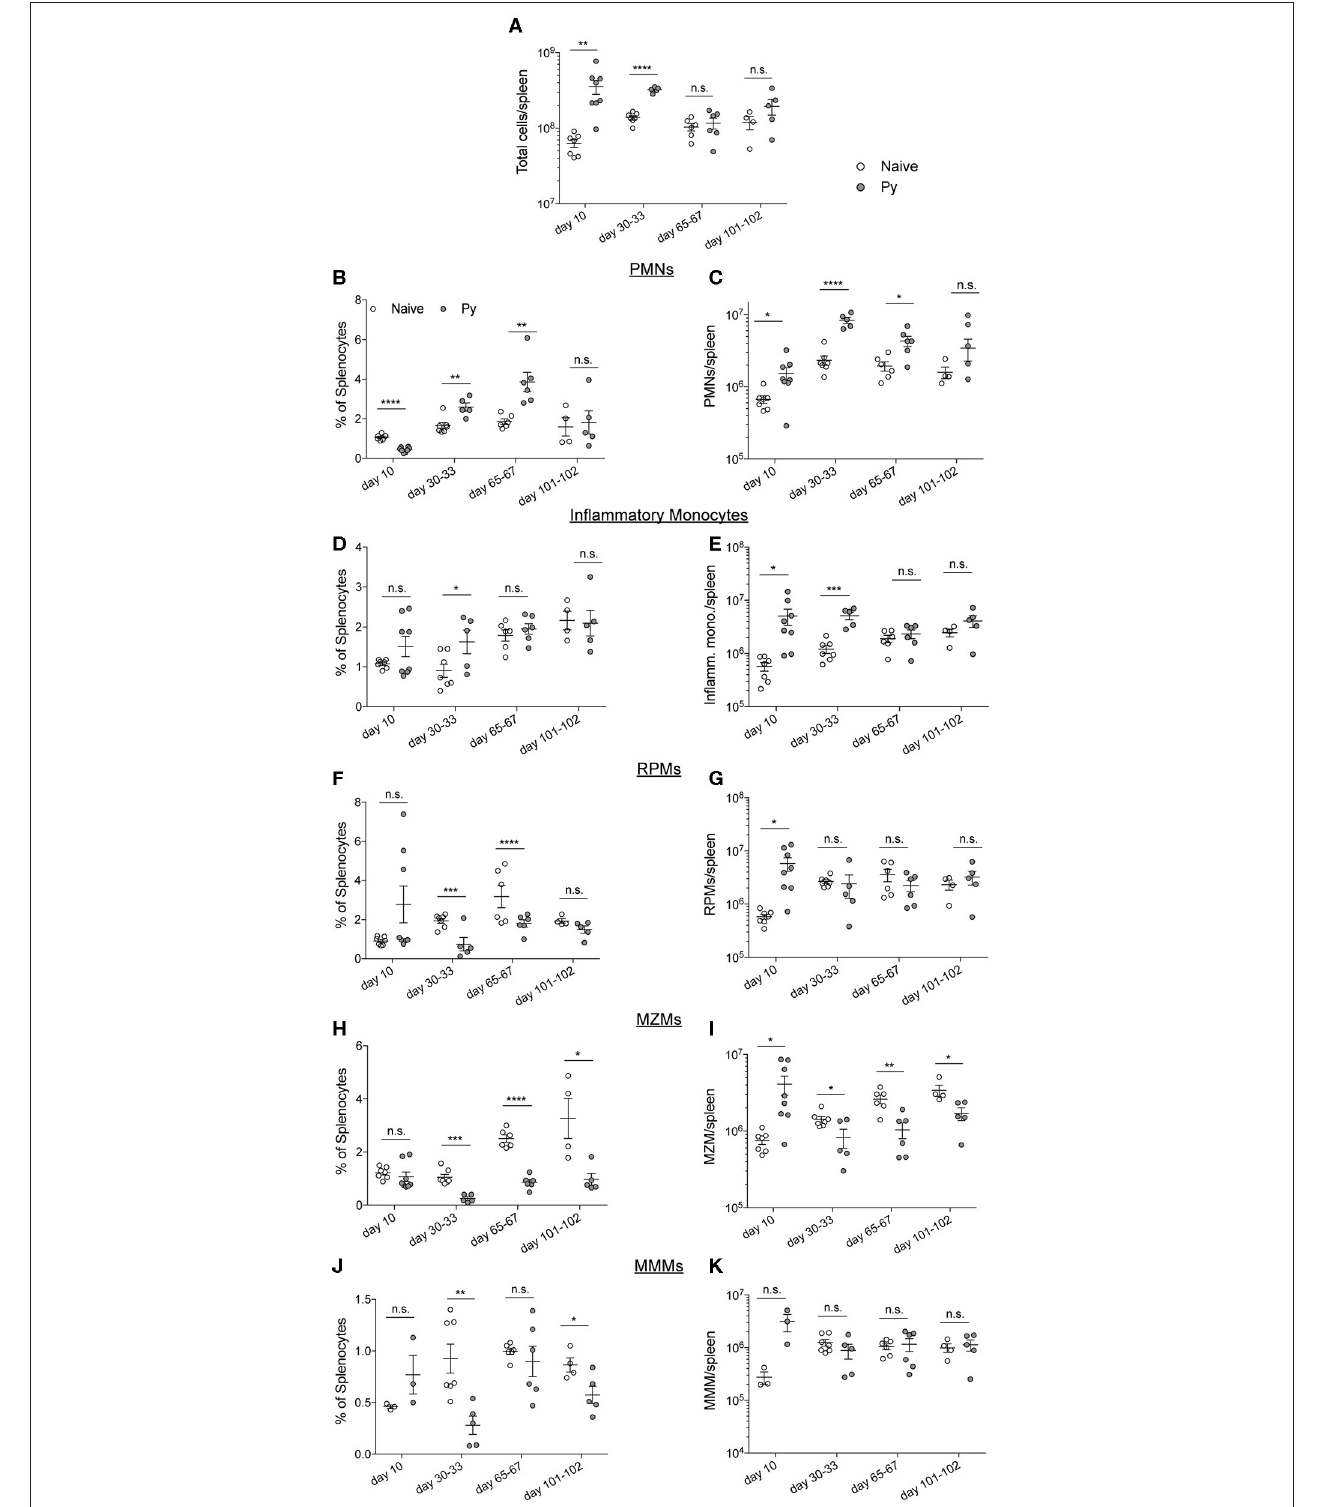
FIGURE 3 | P. yoelii -induced temporal changes in splenic myeloid cell populations do not correlate with impaired immunity during bacteremia. C57BL/6N mice were infected with 10 5 Py pRBCs. Spleens were collected from control or Py-infected mice on the indicated days post infection. (A) Total numbers of cells per spleen on